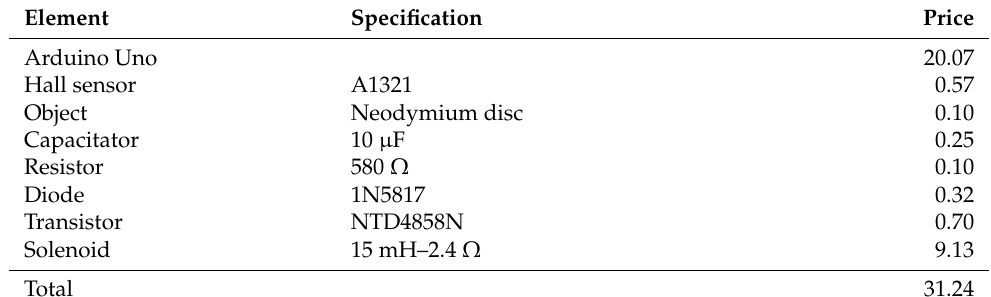
Table 1. Component list and cost calculation in